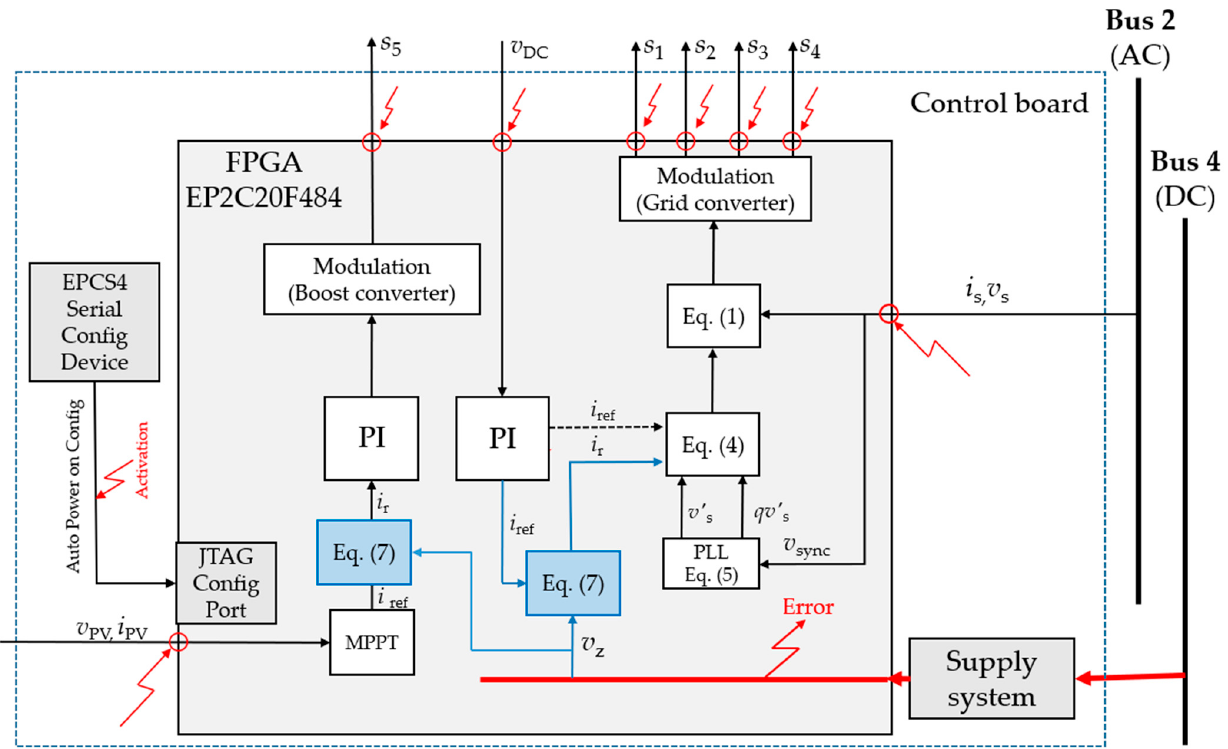
Figure 2. Topology of the control system components located on the control board.